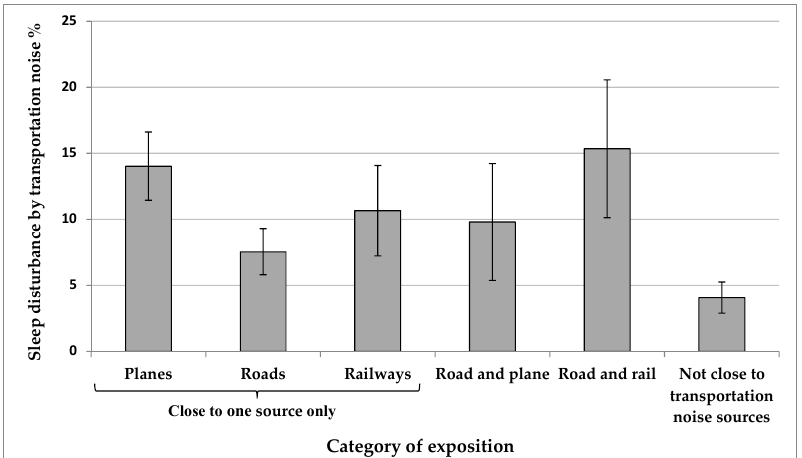
Figure 2. Distance to aircraft NEF25 ( a ), major road ( b ), railways ( c ) and marginal proportions and 95% CI of sleep disturbance by railways in the weighted study sample.